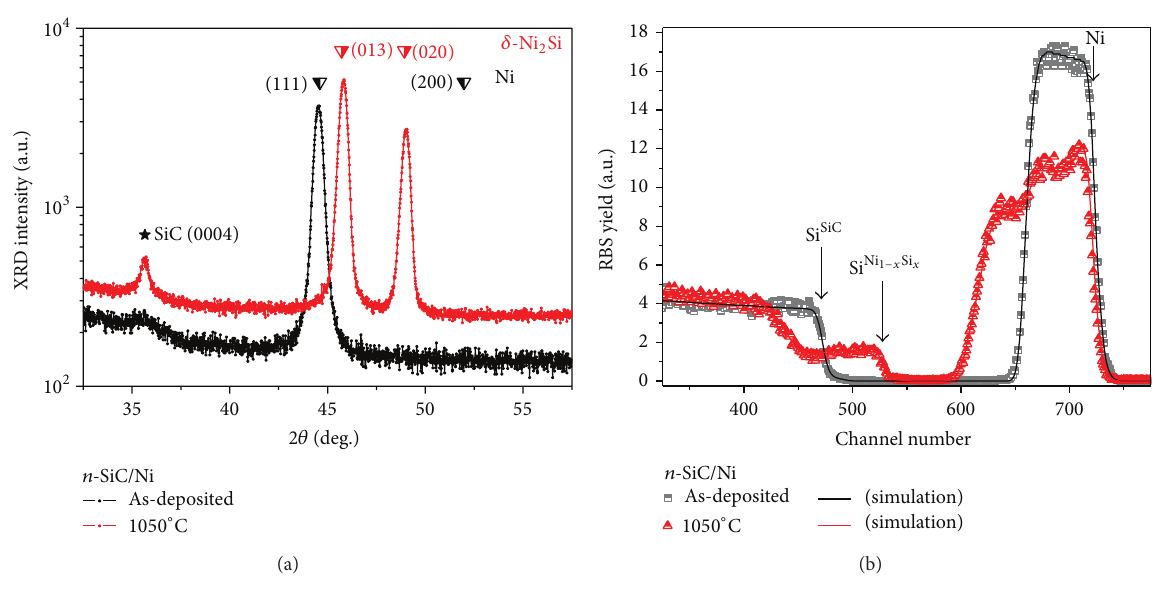
corresponding to the Ni 31 Si 12 hexagonal phase are